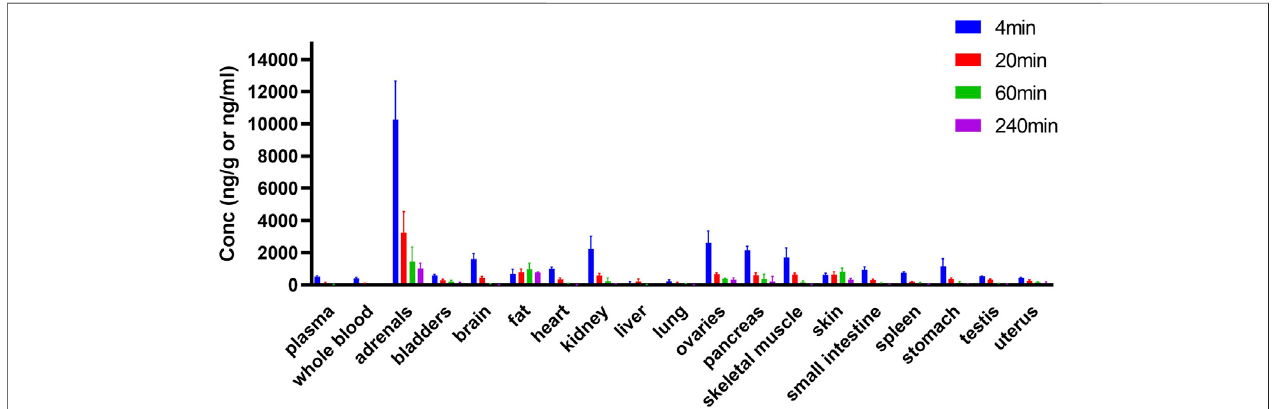
FIGURE 6 | Tissue distribution of HSK3486 in rats following bolus injection ( n = 6 for each point). Twenty four SD rats were randomly assigned to 4 groups, 3/sex/ groupanddosed2 mg/kgHSK3486bybolusinjection.Dosedvolumewas5 ml/kg.4,20,60and240 minafteradministration,ratsweresacri fi cedandwholeblood,as wellasbrain,heart,liver,lung,kidney,bladder,pancreas,testis,ovarian,uterus,stomach,duodenum,adrenalgland,skin(belly),skeletonmuscleandfatwerecollected. Plasma was prepared from collected whole blood. HSK3486 concentration were quantitatively determined by validated LC/MS/MS